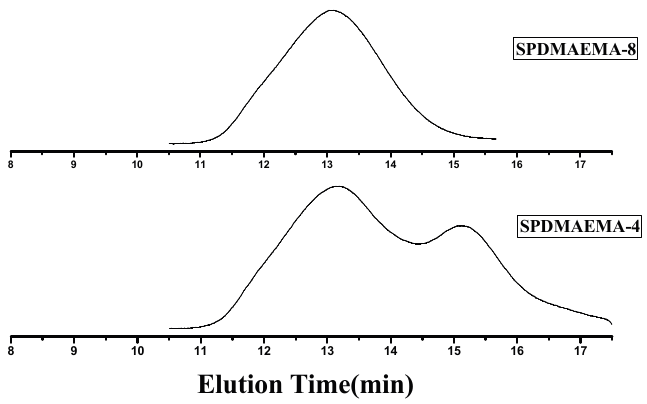
Figure 4. GPC traces of SPDMAEMA-4 and SPDMAEMA-8 (SPDMAEMA-8 was obtained by precipitation fractionation from